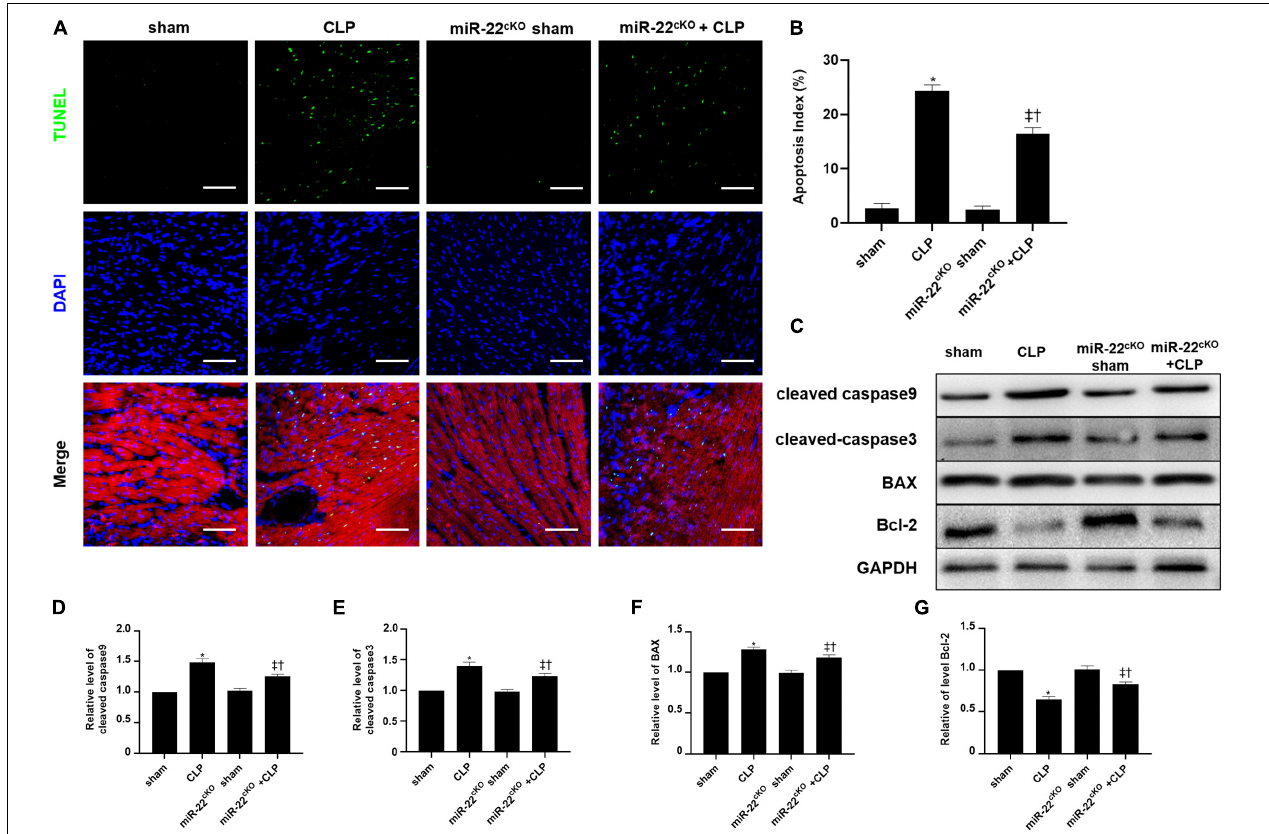
FIGURE 4 | (A) Representative images of TUNEL staining (myocardium); Scale bar = 50 µ m. (B) Percentage of TUNEL-positive nuclei. (C) Representative Western blots. (D) Relative cleaved-caspase9 protein level ratio. (E) Relative cleaved-caspase3 protein level ratio. (F) Relative BAX protein level ratio. (G) Relative Bcl-2 protein level ratio. Data were expressed as mean ± SEM. ∗ P < 0.05 vs. sham group; ‡ P < 0.05 vs. CLP group; † P < 0.05 vs. miR-22 cKO sham